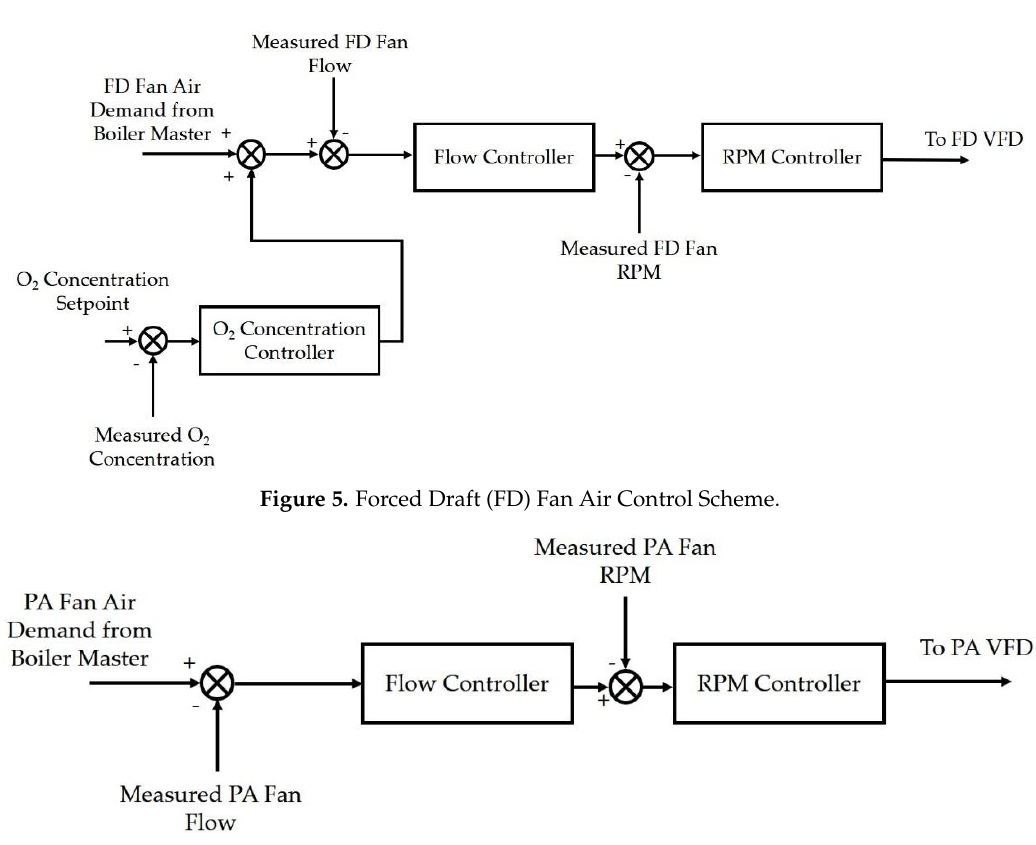
Figure 6. Primary Air (PA) Fan Air Control